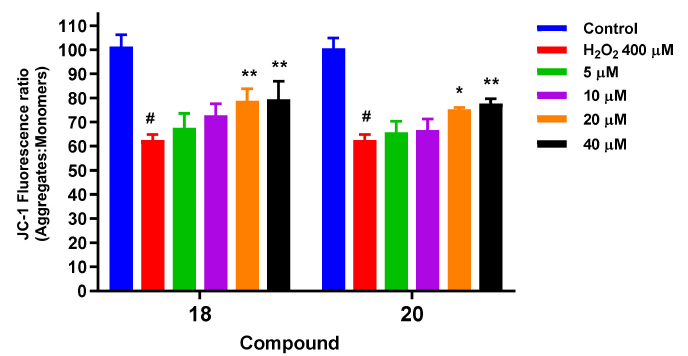
Figure 18. MMP loss is prevented by compounds 18 and 20 in SH-SH5Y under 4-h exposure to 400 µ M H 2 O 2 . Cells were treated with 18 and 20 for 24 h prior to exposure to H 2 O 2 . MMP is expressed as the JC-1 fluorescence ratio in terms of red fluorescence to green fluorescence (Aggregates:Monomers). Data are presented as the Mean ± SEM of four independent experiments carried out in quadruplicate. # p < 0.001 vs. vehicle-treated control. * p < 0.05, ** p < 0.01 vs. cells treated only with H 2 O 2 .